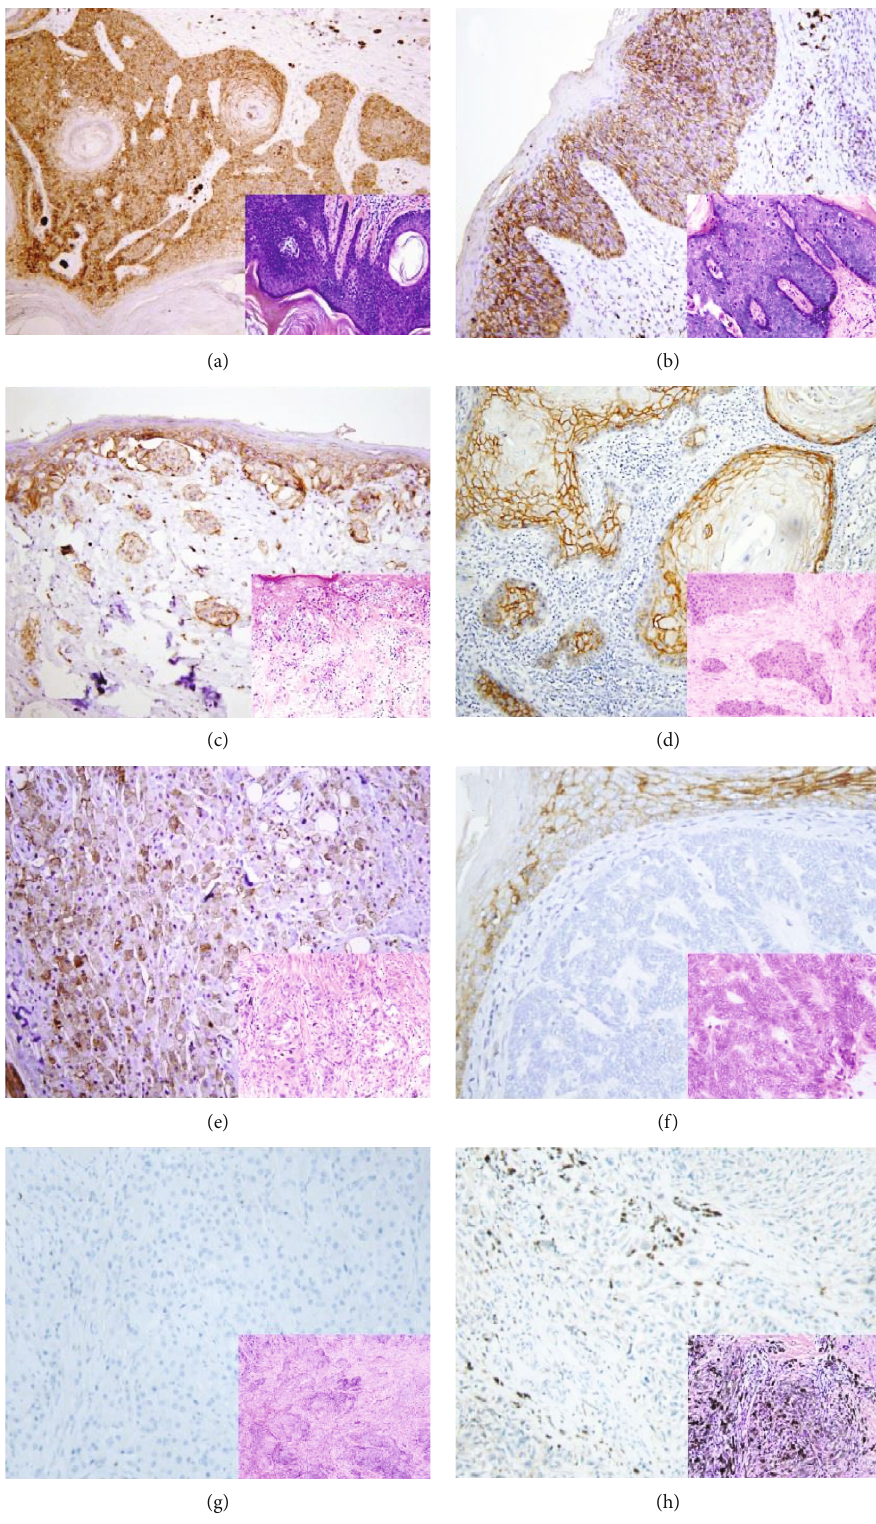
Figure 4: AQP3 expression in malignant skin tumors. Di ff use cytoplasmic membrane staining of AQP3 is identi fi ed in solar keratoses (a), Bowen ’ s disease (b), Paget ’ s disease (c), squamous cell carcinoma (d), and apocrine carcinoma (e), while negative AQP3 staining is observed in basal cell carcinomas (f), sebaceous carcinomas (g), and malignant melanomas (h) with corresponding fi gure of HE staining on the lower right-hand corner (magni fi cation: